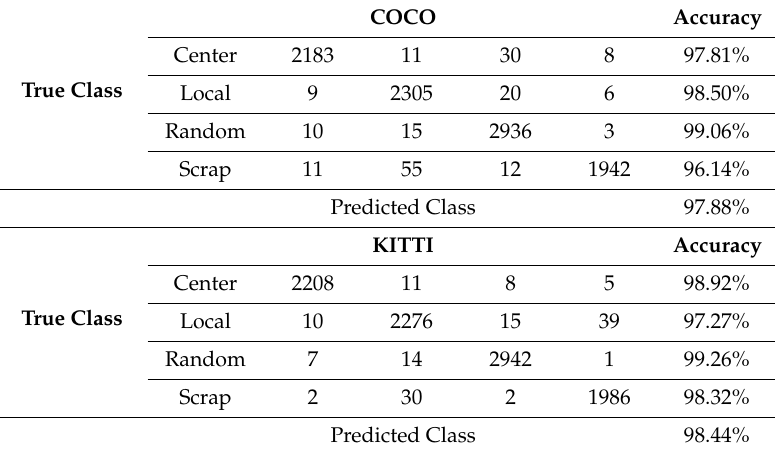
Table 2. Confusion matrices of faster R-CNN trained on COCO and KITTI